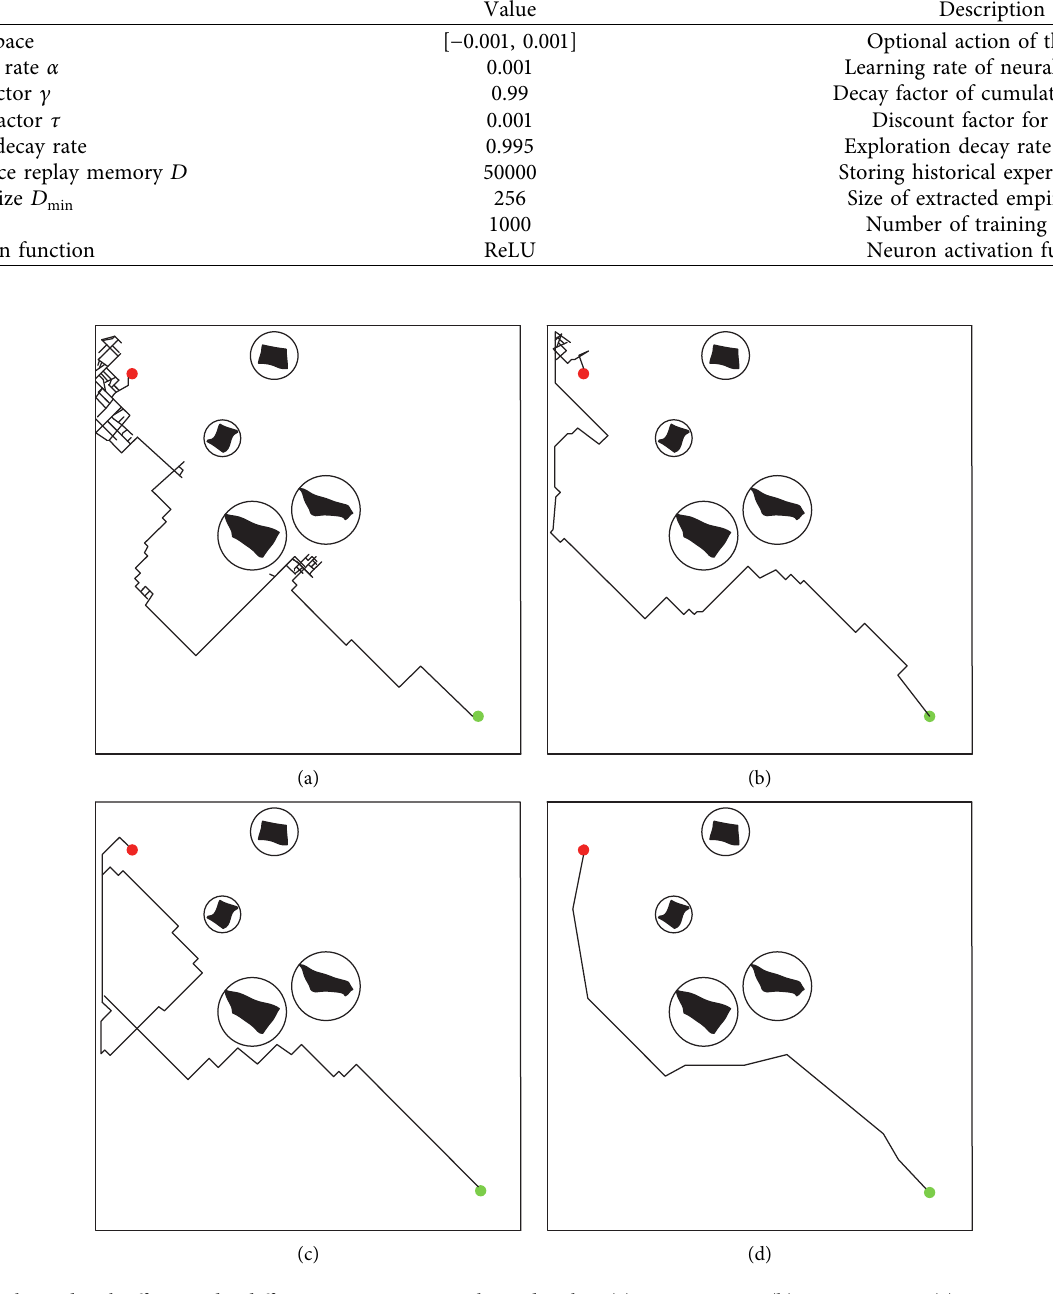
Figure 8: Planned path effects under different iteration times. Planned path at (a) 200 iterations, (b) 600 iterations, (c) 800 iterations, and (d) 1000